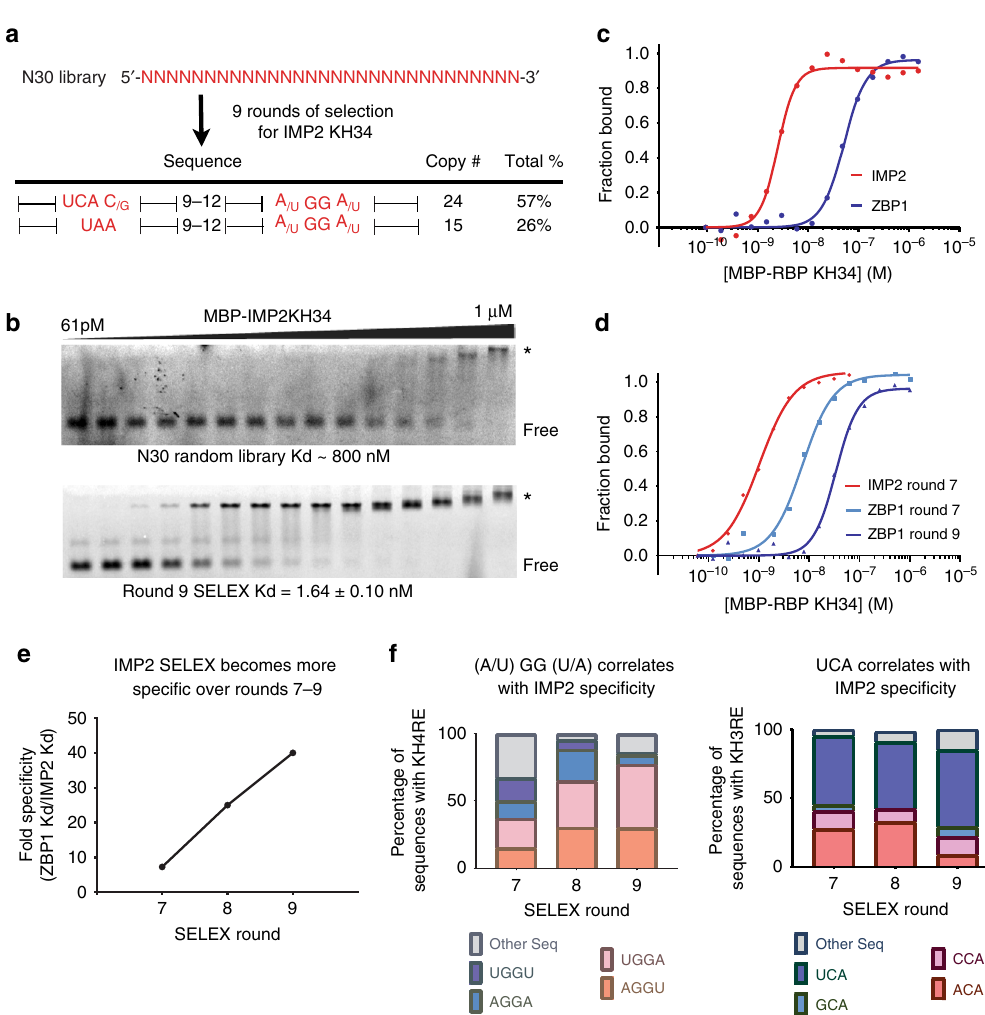
Fig. 2 SELEX discovers targets that are IMP2 speci fi c. a The sequences of RNAs after nine rounds of SELEX are shown. The range of nucleotide spacing between the nonrandomized IMP2 recognition elements is indicated for each sequence. Copy number and percentage of pool are listed. b Representative EMSAs for N30 SELEX library (top) and round 9 SELEX library (bottom). The fi lled triangle represents a 1:1 serial dilution of IMP2KH34. The RBP – RNA complex (*) and free RNA (FREE) are labeled. c Quanti fi cation and fi t to the Hill equation of representative EMSA results for IMP2KH34 (solid red line) and ZBP1KH34 (solid blue line) binding to the round 9 SELEX library pool. d Quanti fi cation and fi t to the Hill equation of representative EMSA results for IMP2KH34 (Round 7, solid red line) and ZBP1KH34 (round 7, solid cyan line, round 9, solid blue line) binding to different SELEX library pools. e Quanti fi cation of SELEX speci fi city for IMP2KH34 within each round SELEX library pool. The library speci fi city was calculated as the ratio between the K d of ZBP1KH34 and the K d of IMP2KH34 at a particular round of selection. f After sequencing each round of SELEX, the individual “ GG ” (left) and “ CA ” (right) motif occurrences were counted as a percentage of total SELEX sequences. The four most abundant motifs were plotted in terms of their relative abundance in each of the sequenced SELEX rounds. Source data are provided as a source data fi